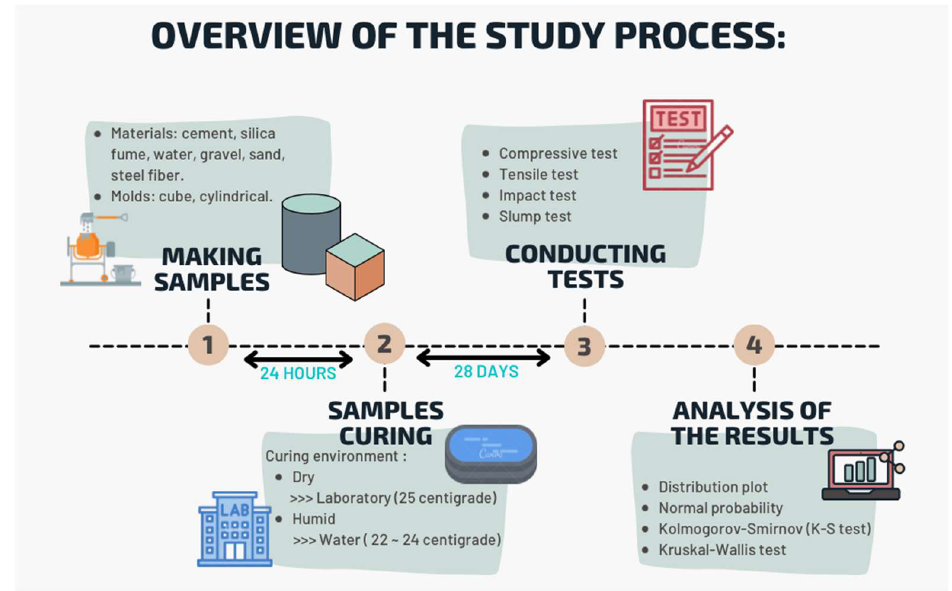
Figure 1. Overview of the study process.